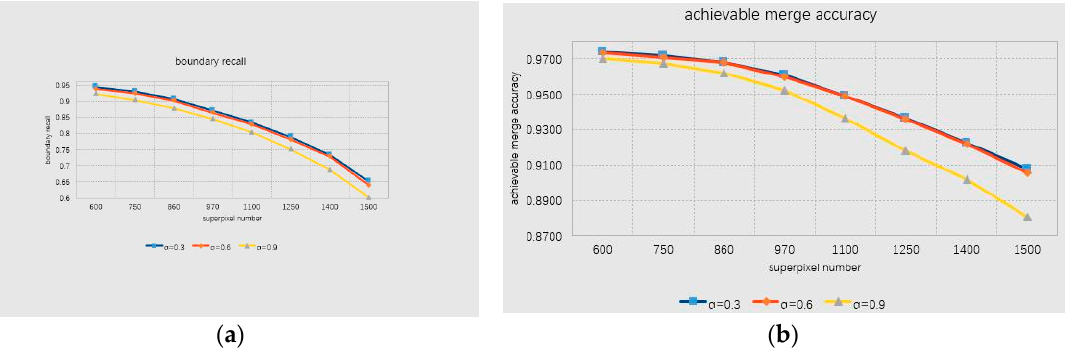
Figure 9. Different α segmentation performances, ( a ) represents the performance curve of different α values of boundary recall, ( b ) represents the performance curve of different α values of achievable merge accuracy. We set the function 𝑓(𝑥) = −𝑥 𝑙𝑜𝑔(𝑥) , 𝛾 = 0.3 .